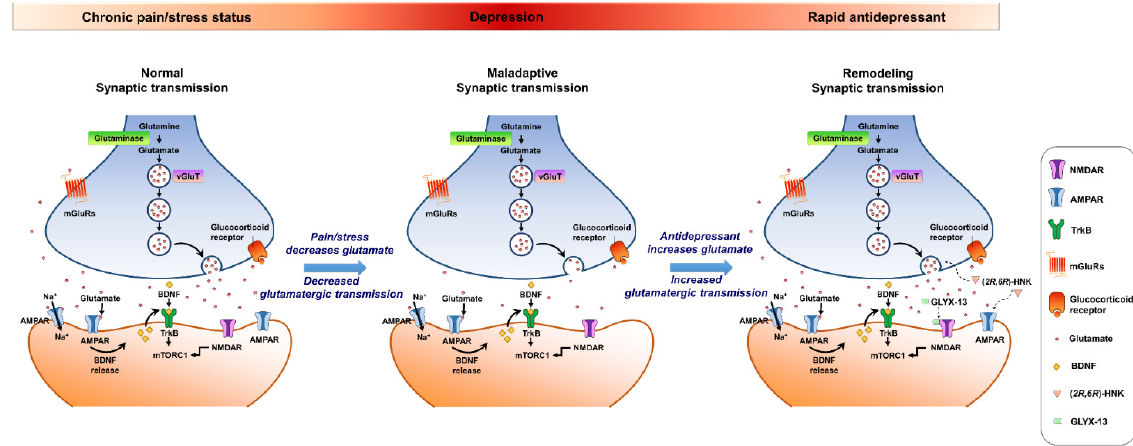
Figure 2. A proposed model for the maladaptation of synapses caused by chronic stress and proposed mechanisms of action of glutamatergic agents in the midbrain ventrolateral periaqueductal gray (vlPAG). Synaptic strength in the vlPAG is maintained at normal neural activity, but is diminished by chronic stress exposure, which depresses glutamate release presynaptically and AMPAR expression postsynaptically. ( 2R,6R )-hydroxynorketamine (HNK), the metabolite of ketamine that exhibits a fast-acting antidepressant effect, can rapidly reverse the effects of chronic stress by releasing a large amount of glutamate that leads to the insertion of AMPARs onto the postsynaptic membrane. GLYX-13, a partial agonist at NMDARs, is hypothesized to initiate mammalian targets of rapamycin complex 1 (mTORC1) and subsequently induce protein synthesis. GLYX-13 requires AMPARs activation and triggers activity-dependent brain-derived neurotrophic factor (BDNF) release. AMPARs activation increases BDNF release, engages the tropomyosin receptor kinase B (TrkB) receptor, and eventually triggers protein synthesis by activating the mTORC1 cascades. It is noteworthy that similar maladap- tive synaptic transmission was observed in preclinical models of chronic pain, another risk factor for